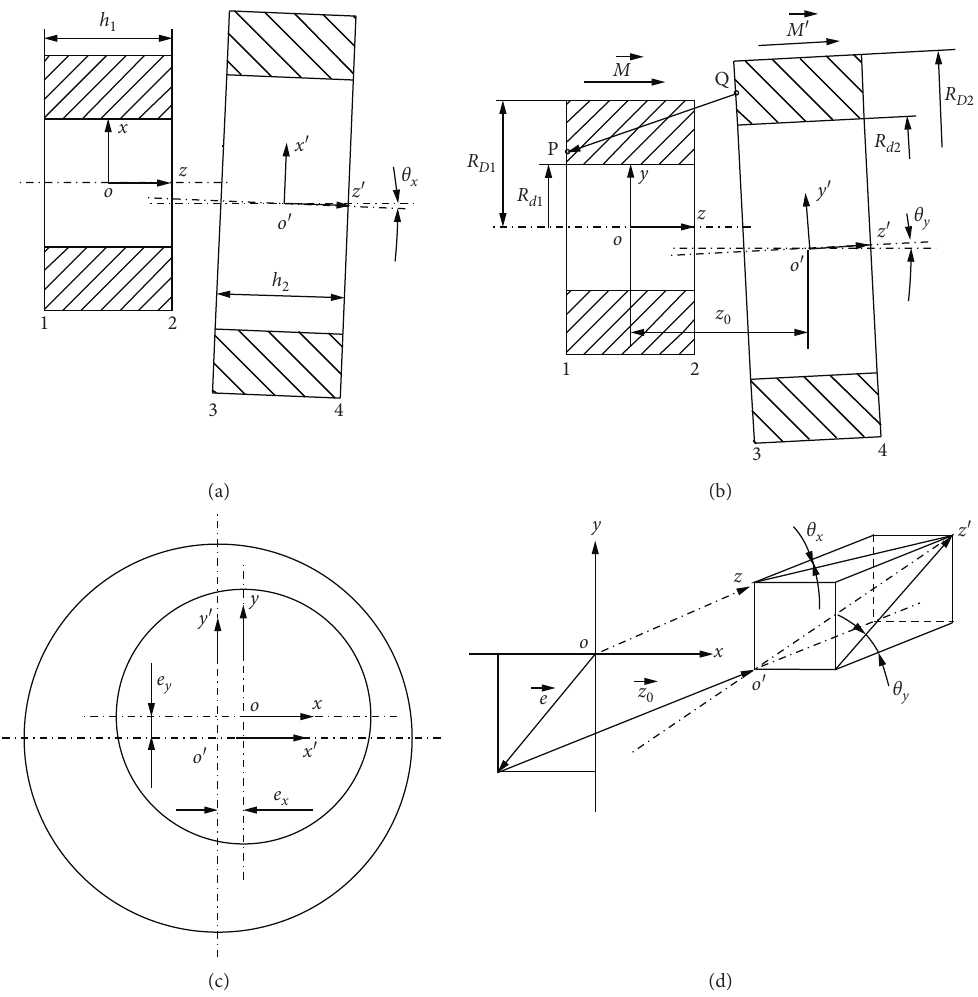
Figure 2: Schematic of the coupling of two PM rings: (a) xoz of PM ring 1 and PM ring 2; (b) yoz of PM ring 1 and PM ring 2; (c) xoy of PM ring 1 and PM ring 2; (d) the relative position between o and o